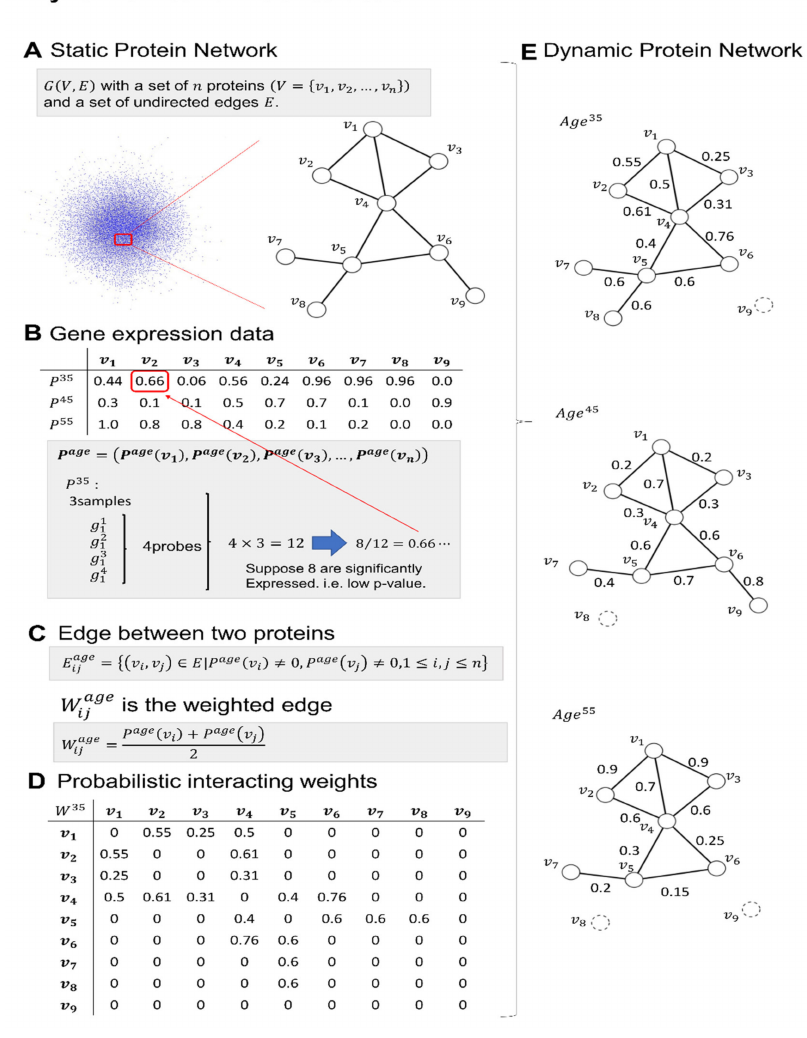
Figure 1. Illustration of the construction of dynamic weighted protein networks. ( A ) Example of a static protein network. The static protein network was constructed from the HINT database. ( B )